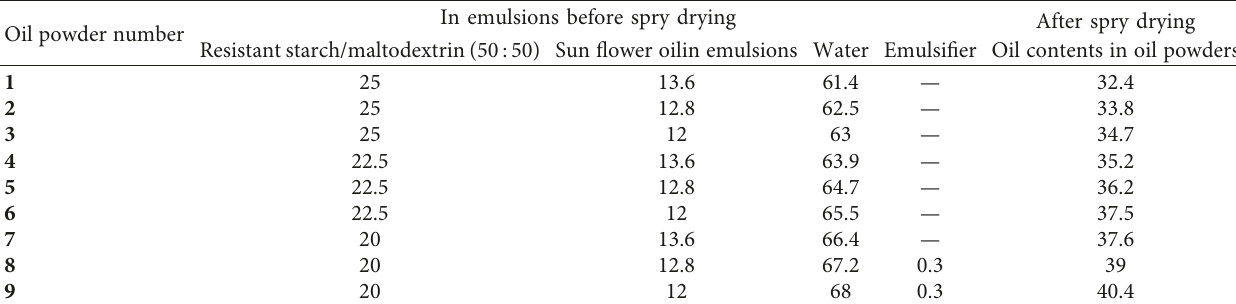
Table 1: Components of oil powders Emulsions (%).